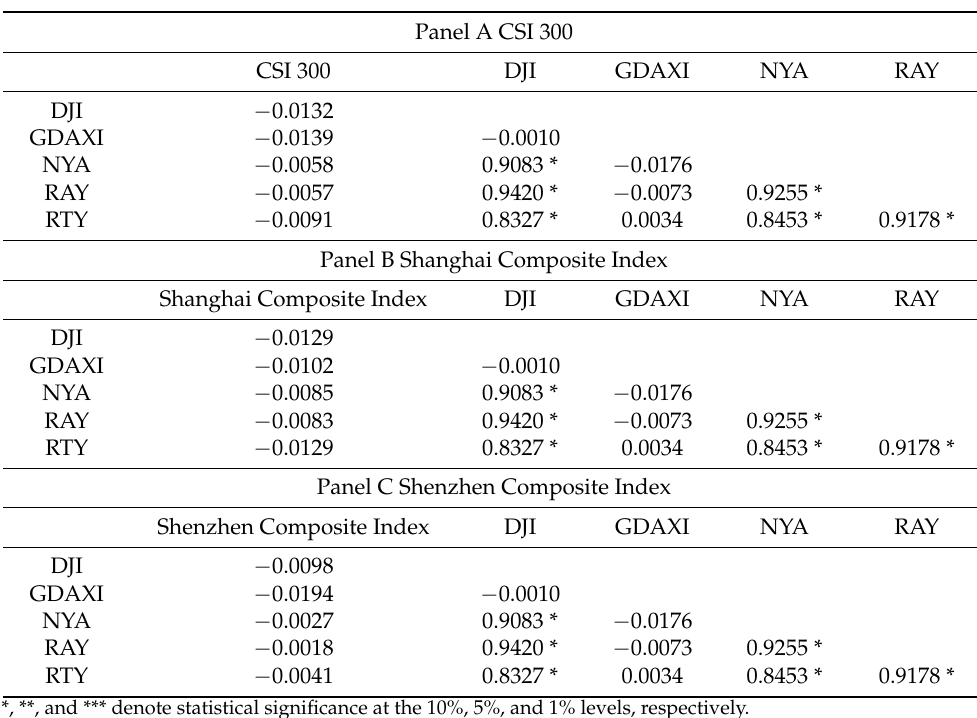
Table 4. Correlation between overnight return of main indexes of Chinese and daytime return of the US and European markets. This table reports the Pearson correlation coefficients between overnight return of main indexes of Chinese and daytime returns of overseas market. DJI, NYA, RAY and RTY are main indexes of the US stock markets. GDAXI is main index of Germany stock market. The main stock market index information is shown in Appendix